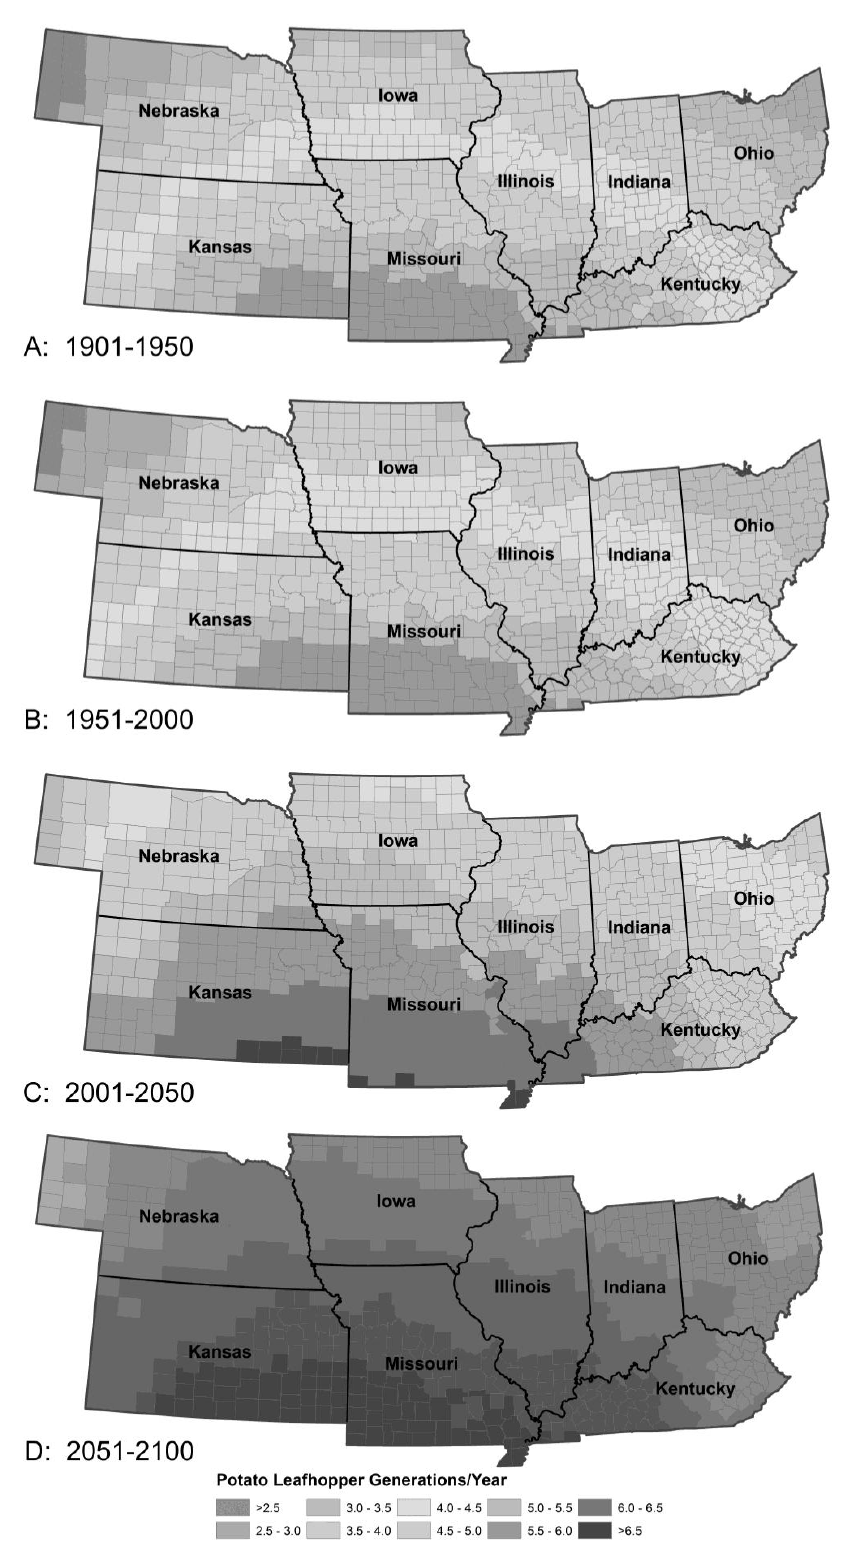
Figure 6. The model predicted little change in number of generations per year of potato leafhopper between Periods 1 ( A ) and 2 ( B ) with a dramatic increase in the number of generations in the northern and western counties in Period 3 ( C ) and increased number of generations everywhere in Period 4 ( D ).